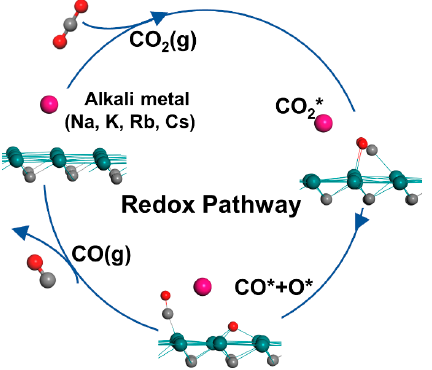
Figure 4. The most stable adsorption configurations of all possible surface intermediates as well as the adsorption energies (in Kcal/mol) on Mo 2 C and X − Mo 2 C (X = Na, K, Rb, and Cs). The species with asterisks (*) represent adsorbed species. Color codes: Mo—green, carbon—grey, O—red.